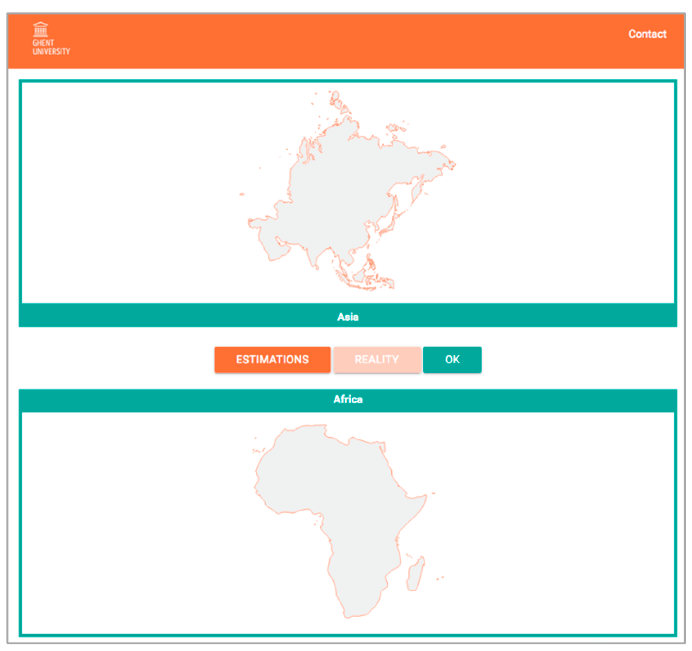
Figure 6. Feedback-tool demonstrating the estimated (button “ESTIMATIONS”) and real (button “REALITY”) proportions of two test regions.